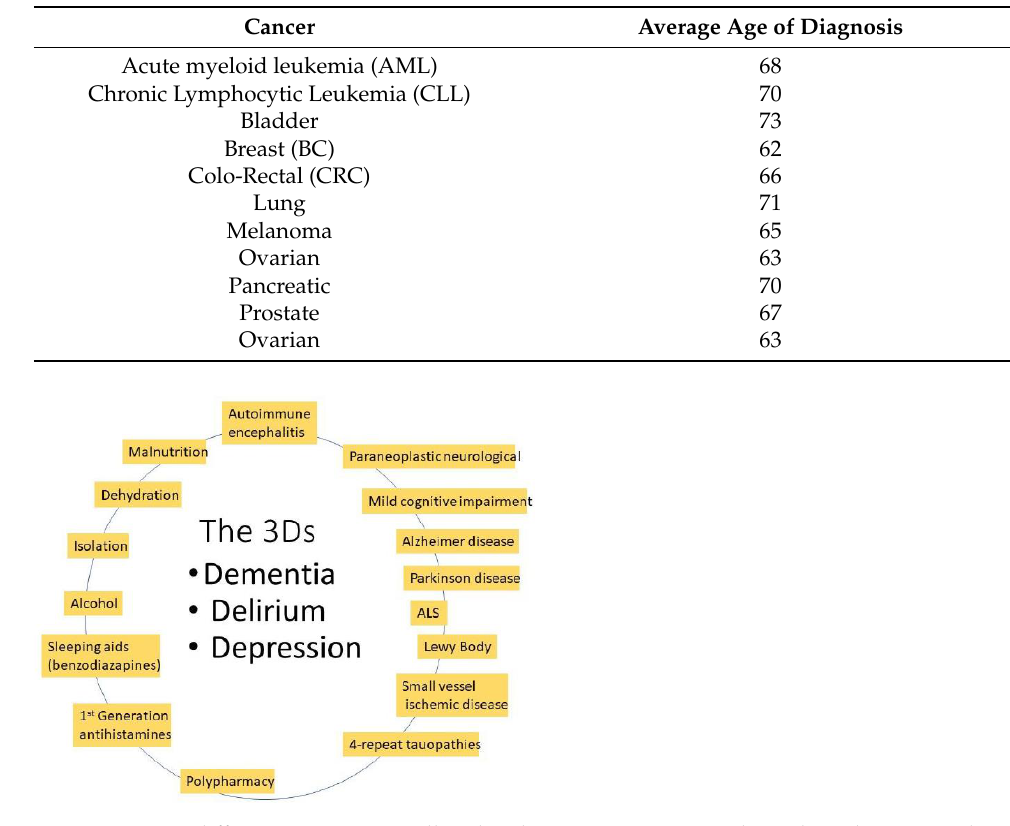
Figure 1. Many different environmentally related or progressive neurological syndromes can have similar “3D” symptoms. Table 1. More than half of cancers are diagnosed in people older than 60 years. The table lists cancers whose median age of diagnosis is above 60 years. Except for ovarian (54 – 65), most cases are diag- nosed between the ages of 65 –